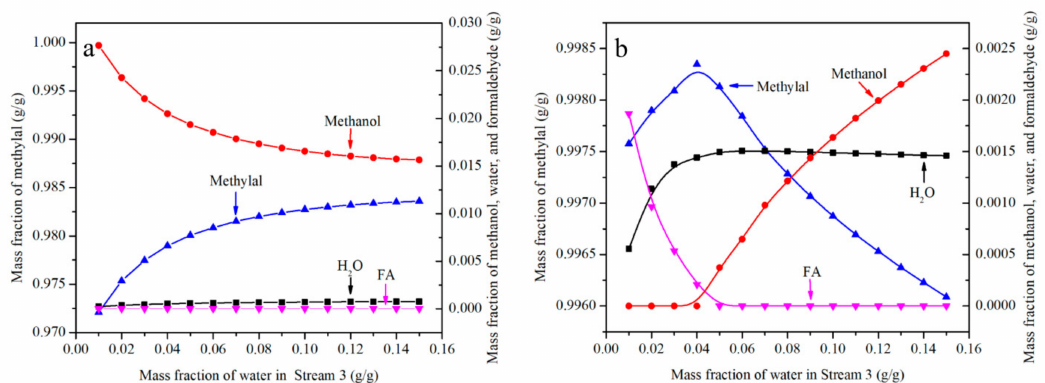
Figure 6. The e ff ect of water content on e ffl uent from the top of distillation column. (( a )—FA / MeOH ratio = 1, ( b )—FA / MeOH ratio = 2).